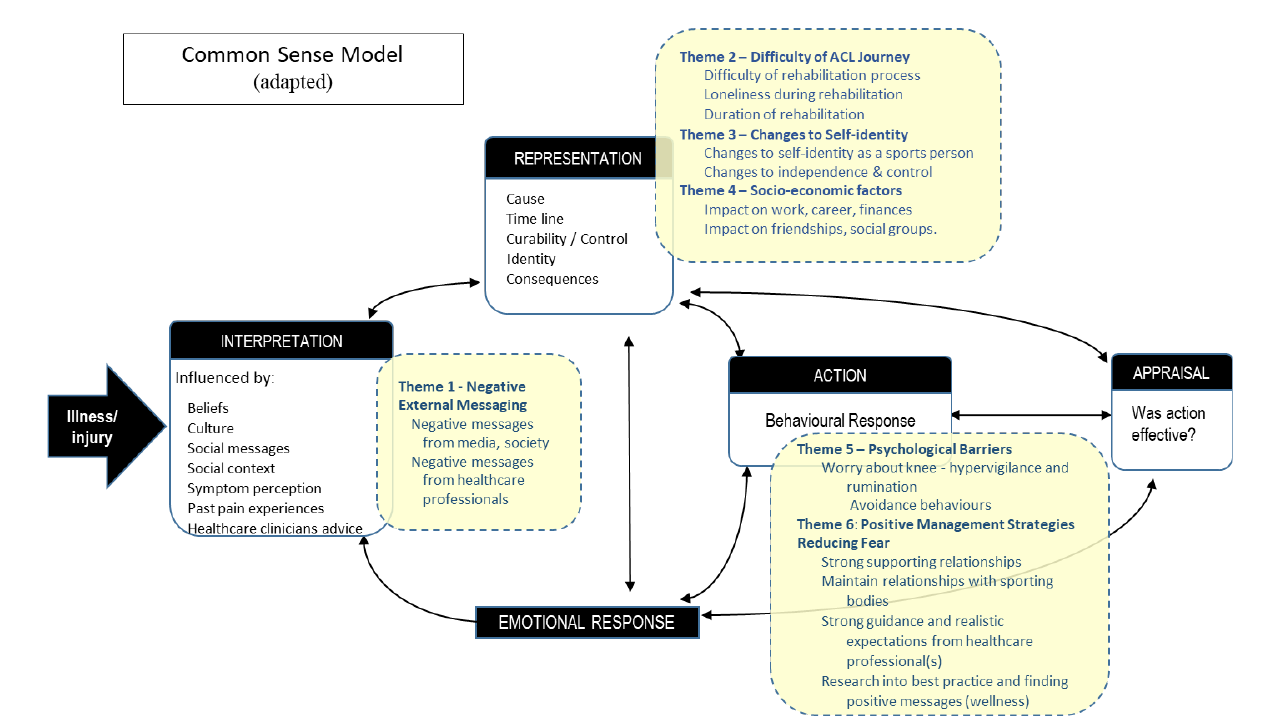
Figure 2. Common-Sense Model (based on the work of Leventhal—various papers 1965–2016). Themes and subthemes in subjects with above-average fear at least one year after an ACL injury, mapped to the Common-Sense Model.